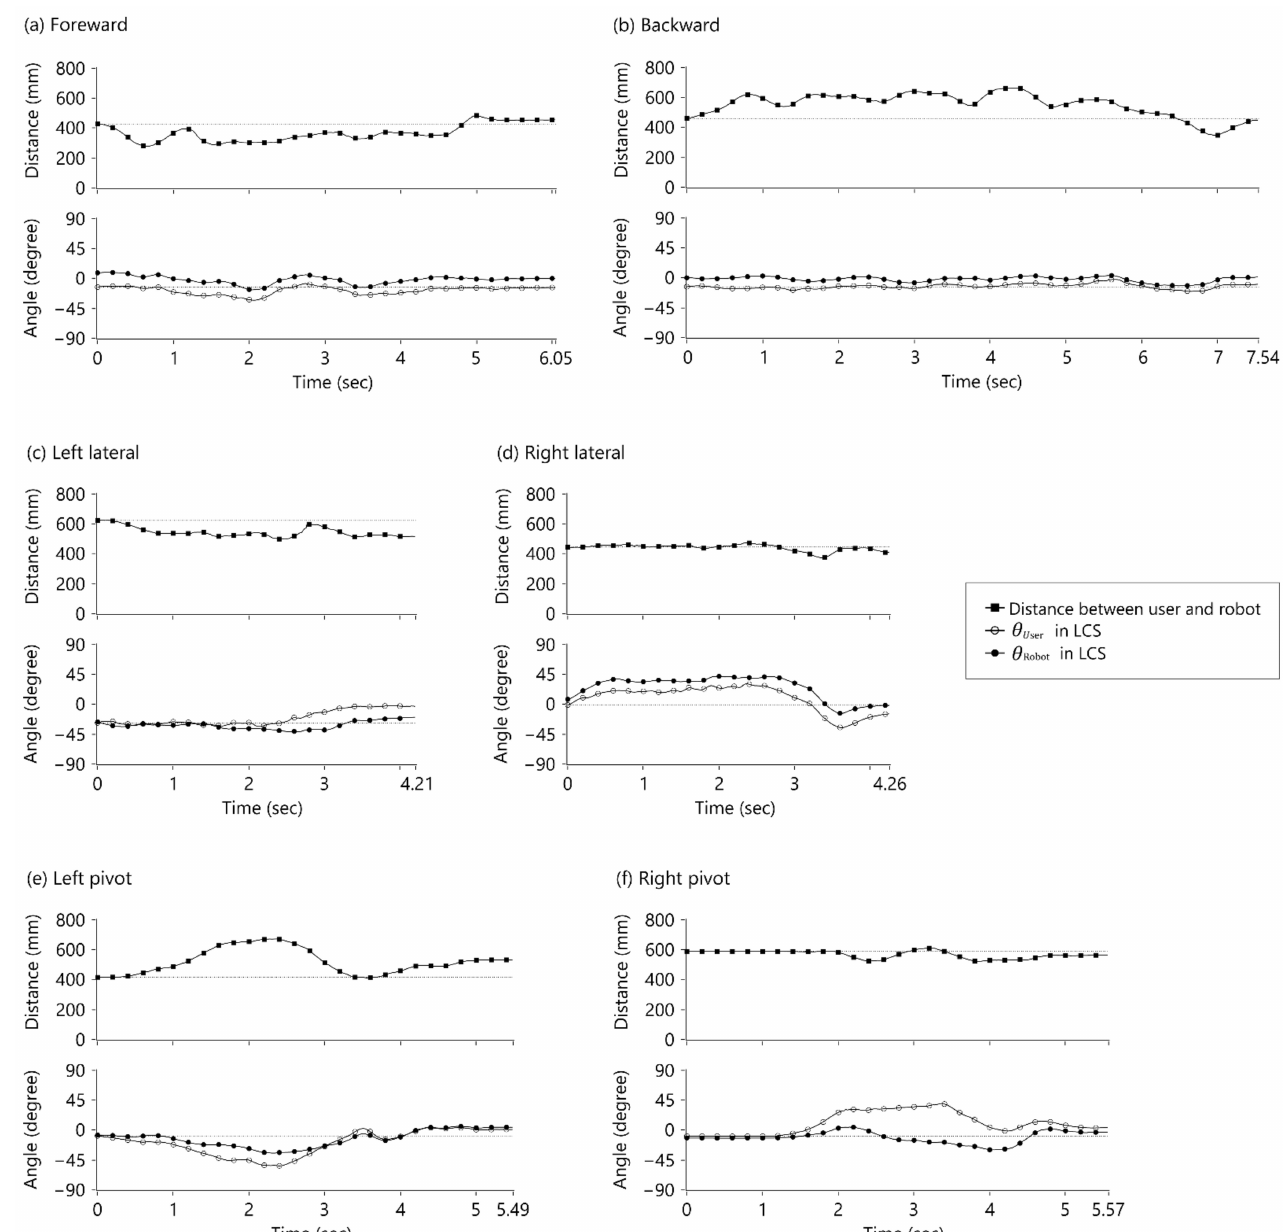
Figure 7. Relative distance between the robot and the user w.r.t. the LCS and encoder values θ Robot , θ User in the LCS. ( a ) Forward walking test; ( b ) backward walking test; ( c ) left lateral walking test; ( d ) right lateral walking test; ( e ) walking test with pivot turning to the left; ( f ) walking test with pivot turning to the